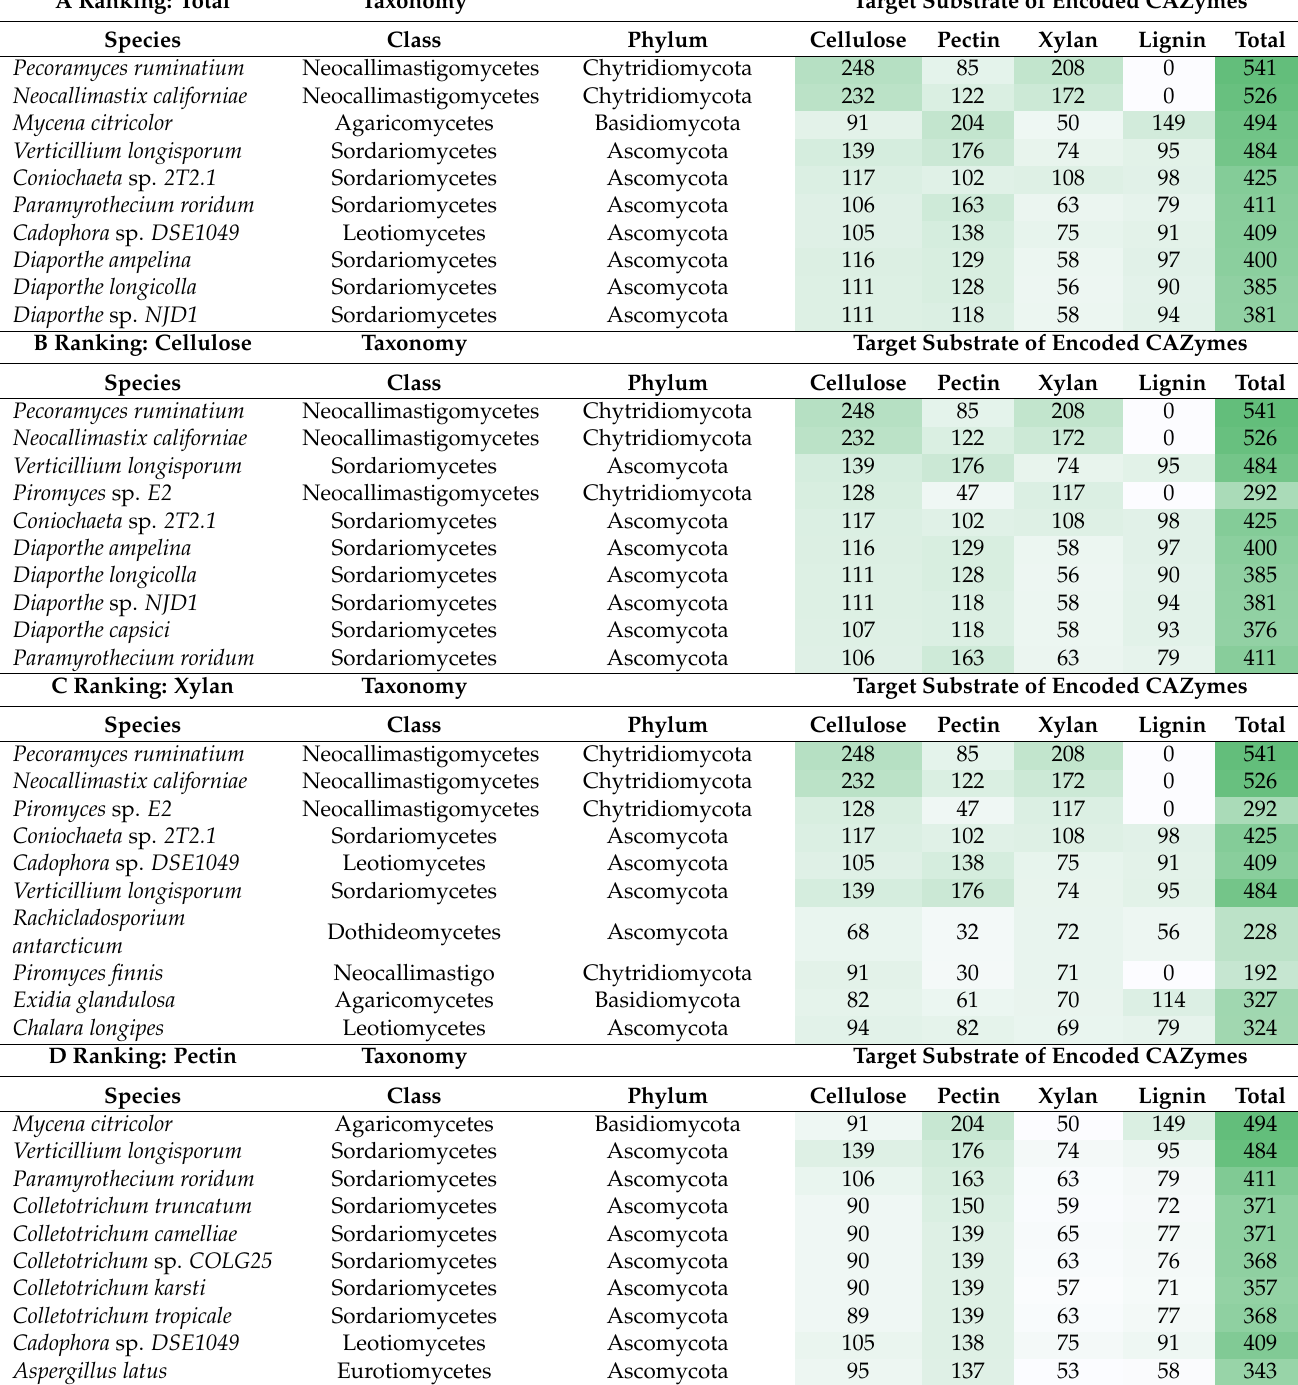
Table 1. Listing of the ten top-ranked species with regard to biomass degrading capacity, (all observations included), specifying the number of “Function;Family” observations. The table includes ranking according to “Total” (A), followed by ranking according to enzyme observations with affinity for each of the target substrates, Cellulose (B), Xylan (C), Pectin (D) and Lignin (E). The total list of observations for the analyzed 1932 genomes is given in Table